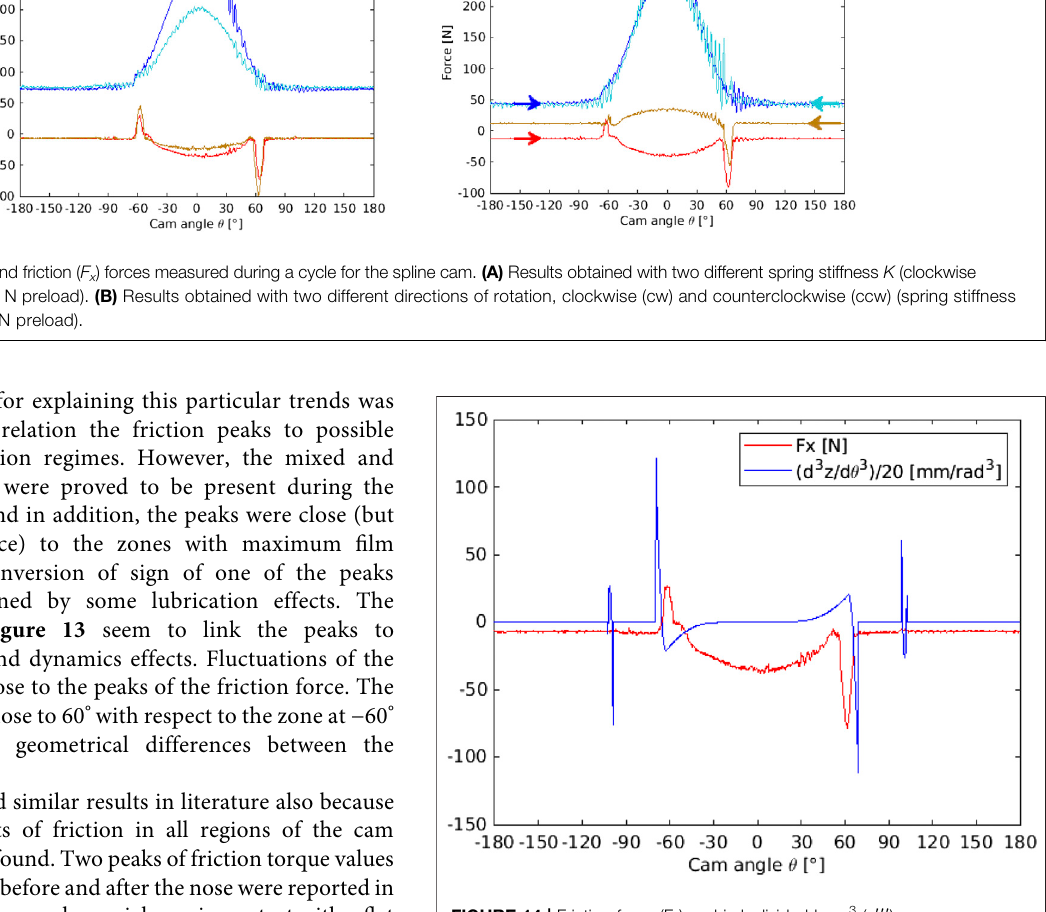
x ) and jerk divided by